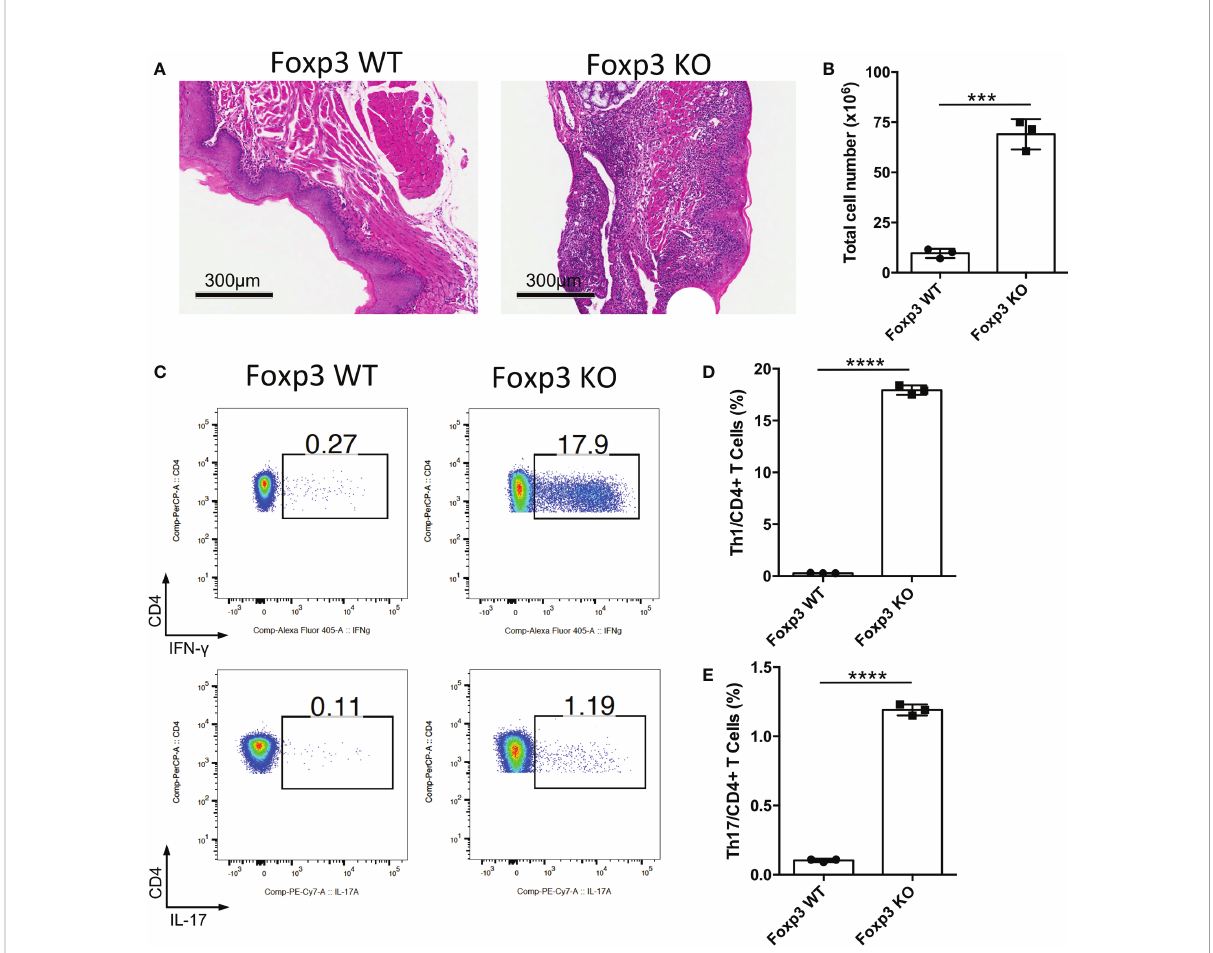
FIGURE 1 Deletion of Treg cells causes severe in fl ammation in oral mucosa. Oral tissues and draining lymph nodes (DLNs) of Foxp3 +/+ (Foxp3 WT) and Foxp3 -/- (Foxp3 KO) mice were harvested from four-week-old mice (n=3). (A) Representative histology images of oral mucosa sections. Scale bars, 300 m m. (B) Bar graphs showing total cell numbers in DLNs of the oral cavity. (C-E) Representative fl ow cytometry plots (C) and bar graphs (D, E) showing frequencies of CD4 + IFN- g + T cells (Th1 cells) and CD4 + IL-17A + T cells (Th17 cells) in DLNs. Data are representative of two independent experiments. Summary data are presented as mean ± SD. ***p < 0.001; ****p < 0.0001, unpaired two-tailed Student ’ s t